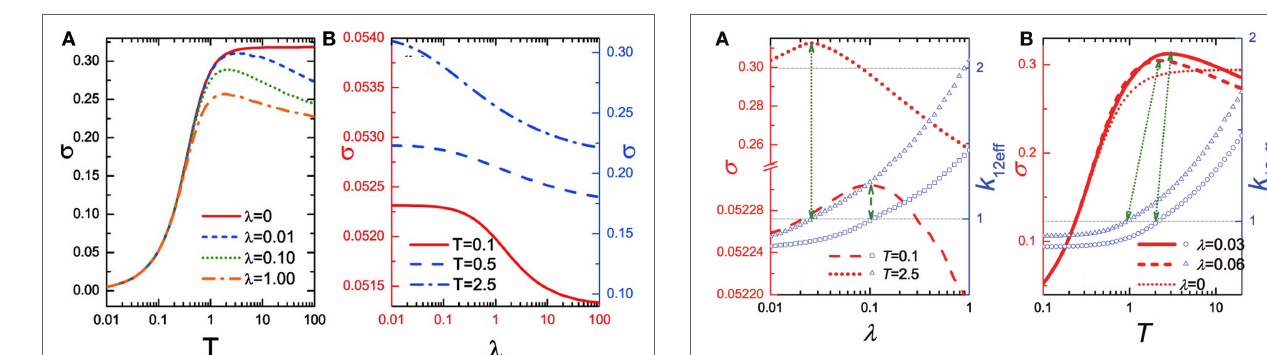
FIGURE 7 | (A) Interfacial thermal conductance σ for homogeneous lattice as a function of the average temperature T = ( T L + T R )/2. (B) Interfacial thermal conductance σ for homogeneous lattice as a function of the interfacial nonlinearity λ . Here, k L = k R = k 12 = 1.0, m L = m R = m 12 = 1.0. The figure has been adapted with permission from the copyright holder (Europhysics Letters), Zhang et al. (2013c).